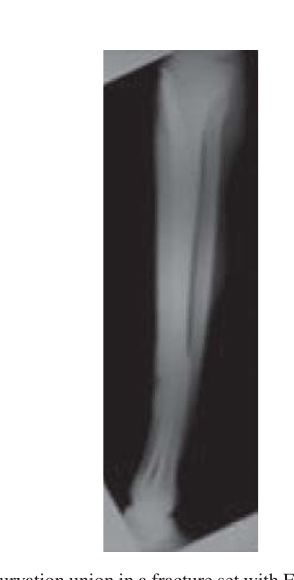
Figure 2 - Recurvation union in a fracture set with Ender pins. Note that the deformity coincides with the angle of the distal ends of the